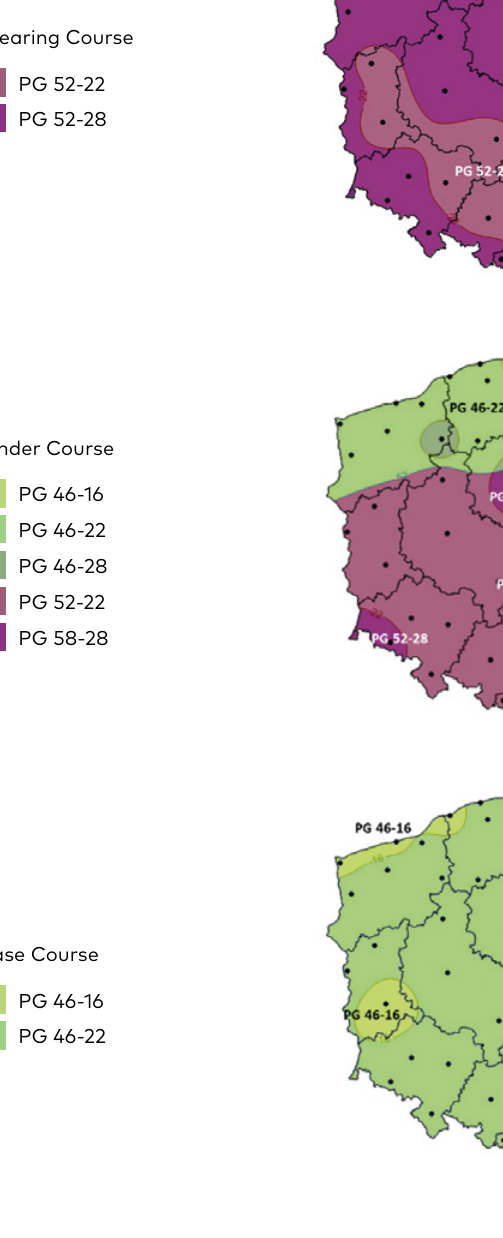
Figure 1. Climatic zones for the Polish area for the Performance